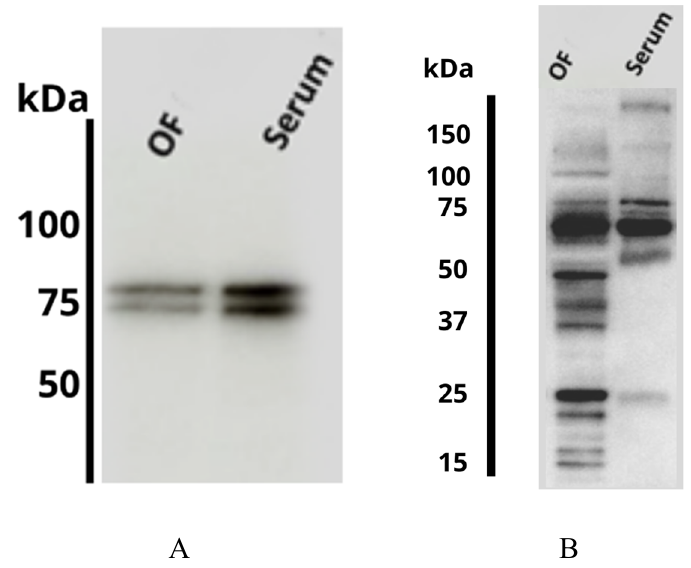
Figure 4. Immunoblot using ( A ) a polyclonal antibody anti-serotransferrin (1:2000) or ( B ) a polyclonal antibody α-1-antiproteinase (1:5000) in bovine oviductal fluid (OF; 0.31 µg) and serum (0.30 µg).